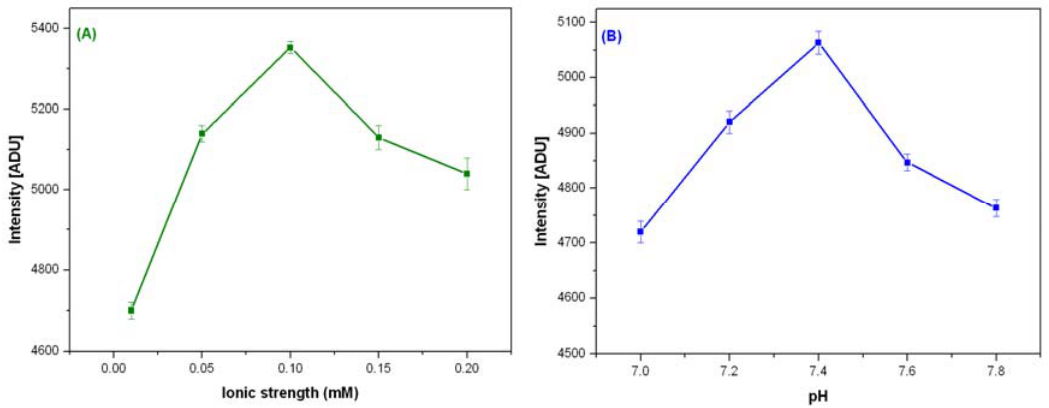
Figure 2. The Figure (A) variation of CL intensity profile for stabilized BuChE at different ionic strength of buffer and Figure (B) Effect of pH on the activity of stabilized BuChE in micro well plate with 0.5 mM BuChCl, 0.1 M PB, pH